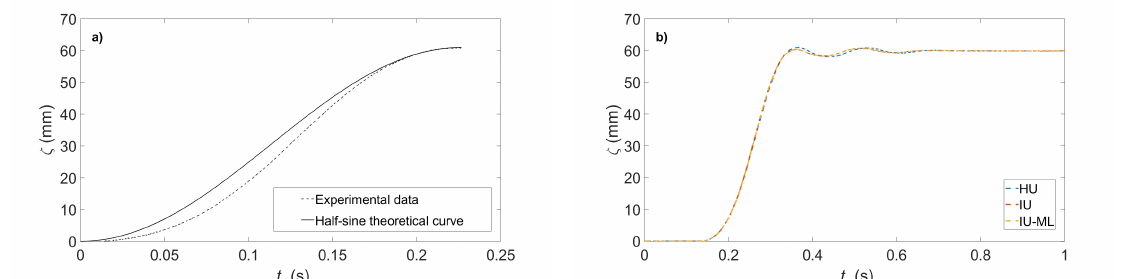
Figure 6. ( a ) Plate displacement ( ζ ) time history, comparing experimental data with a fitted half-sine curve as in Hammack [30]. ( b ) Plate displacement ( ζ ) time history for the different test scenarios: Horizontal Uplift (HU), Inclined Uplift (IU) and Inclined Uplift with Moving Landslide